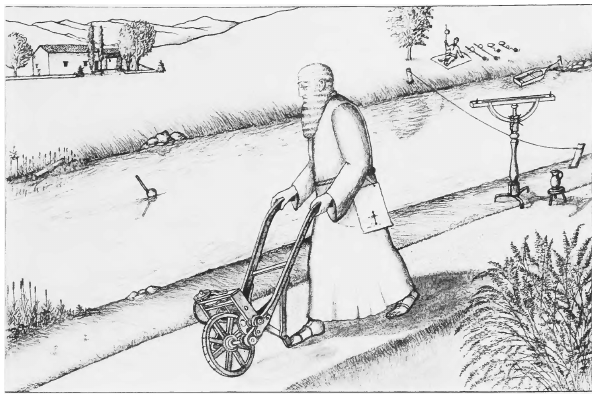
Figure 1. Leonardo da Vinci conducting experiments on the velocity-distribution in streams. Source: Water Current Meters by Frazier